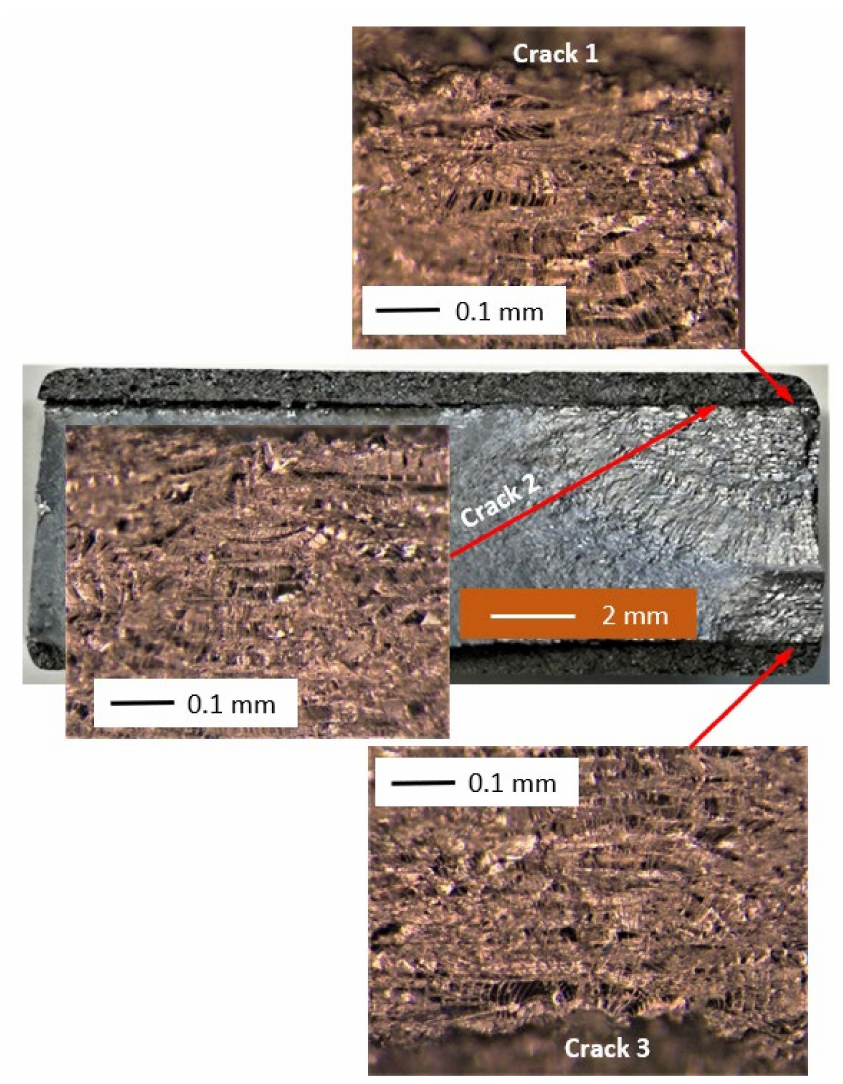
Figure 3. Failure surface associated with test specimen 2.